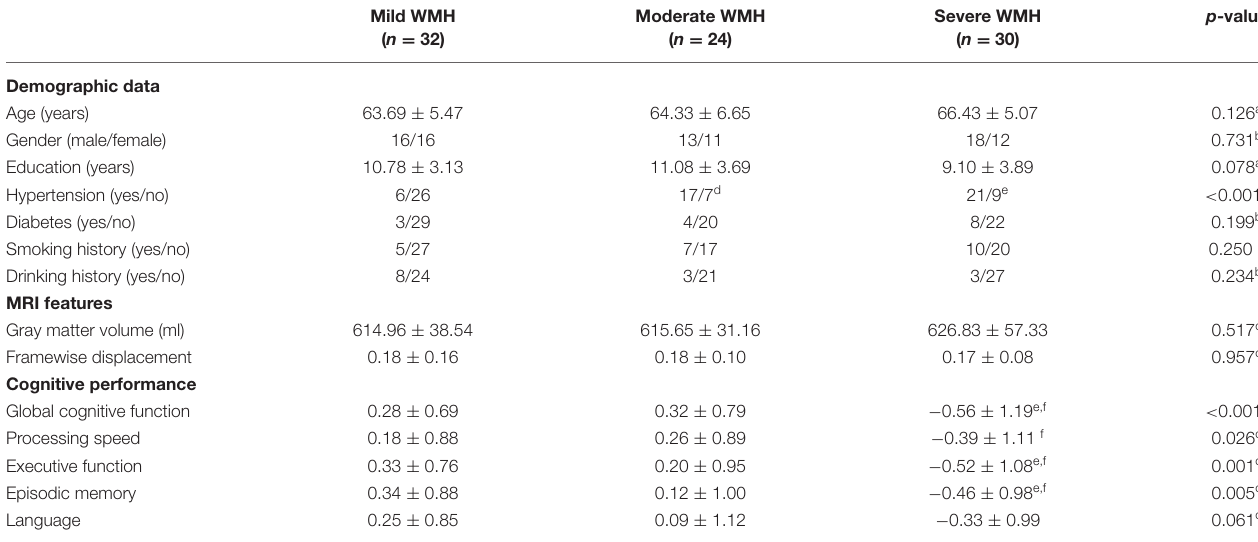
TABLE 1 | Demographic and clinical features of